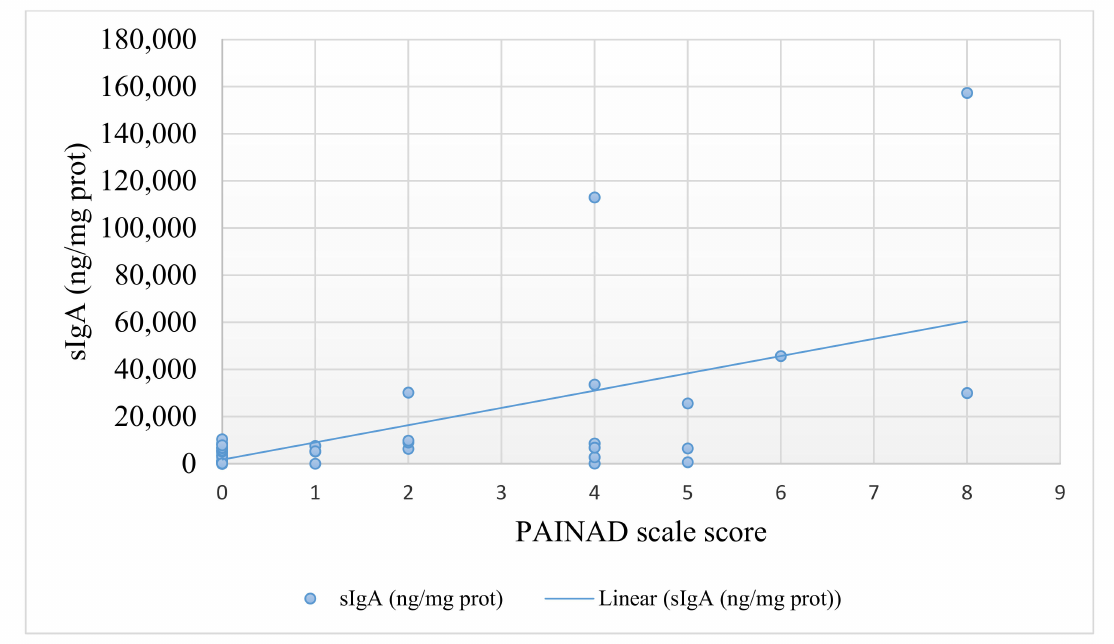
Figure 2. Association between pain assessment in advanced dementia (PAINAD) numerical score and sIgA (ng/mg protein)